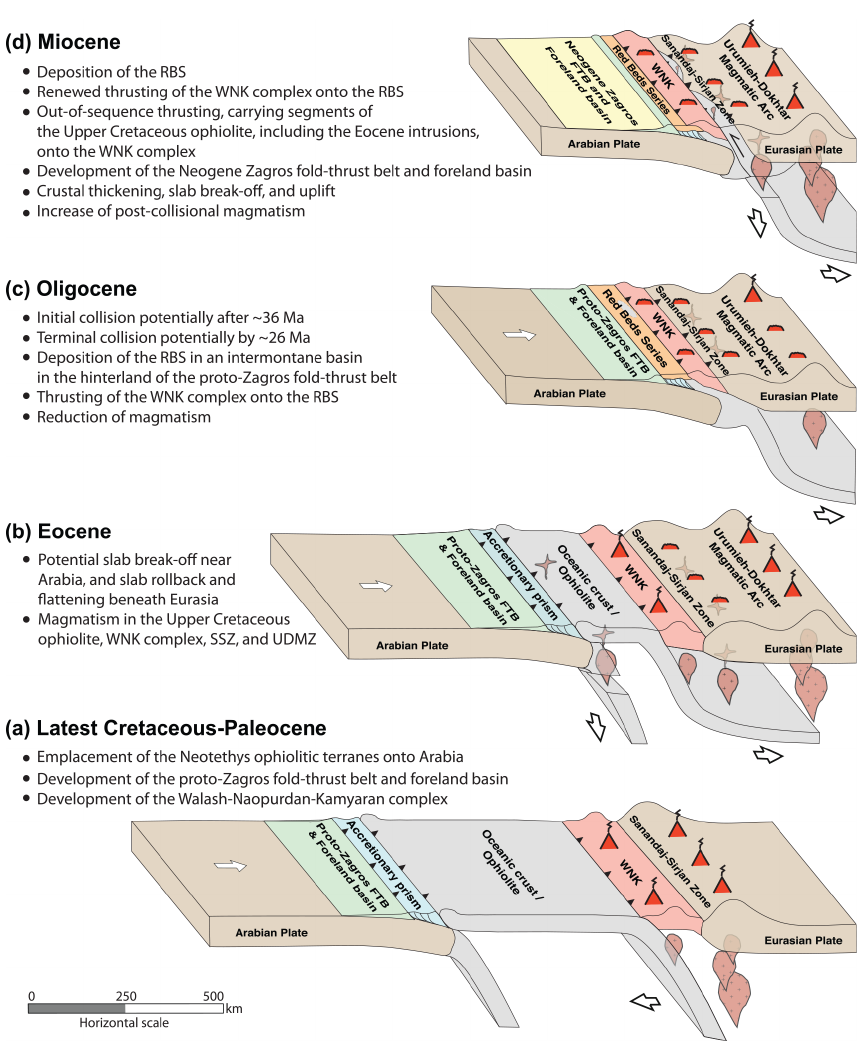
Figure 13. Schematic illustrations portraying the late-Mesozoic–Cenozoic history of the Arabia–Eurasia convergence and the NW Zagros suture zone evolution. The possible configuration of the subducted Neotethys oceanic slabs, and the Arabian and Eurasian Plate margins are constrained by the results of this study as well as previous data and interpretations (Agard et al., 2005; Barrier and Vrielynck, 2008; Omrani et al., 2008; Agard et al., 2011; Moghadam and Stern, 2011; Agard et al., 2011; Mouthereau et al., 2012; Whitechurch et al, 2013; Ali et